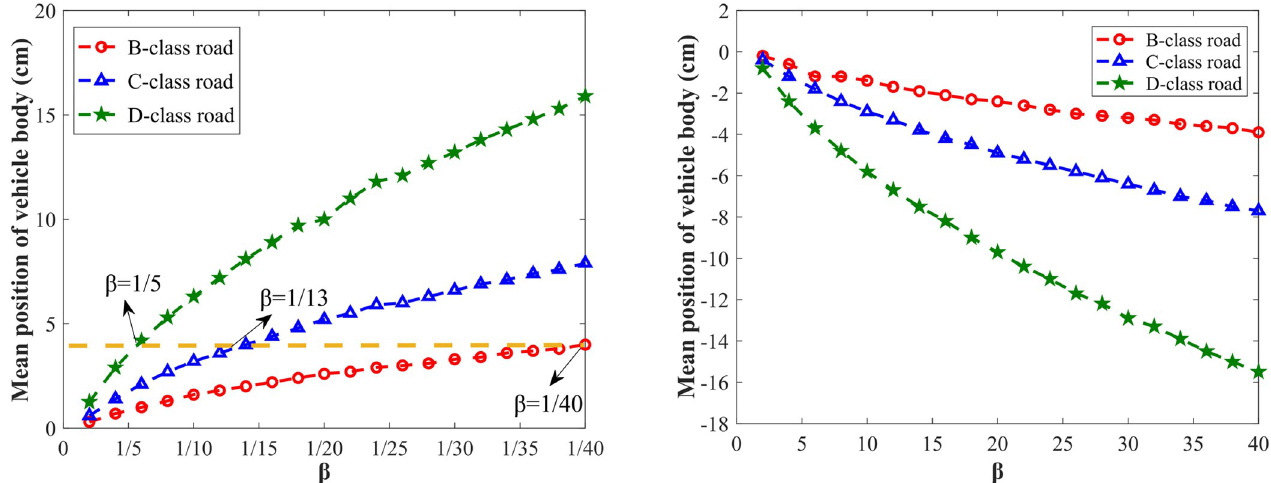
Fig 12. Vehicle body’s mean position with different β and roads. (A) Vehicle body raises; (B) Vehicle body